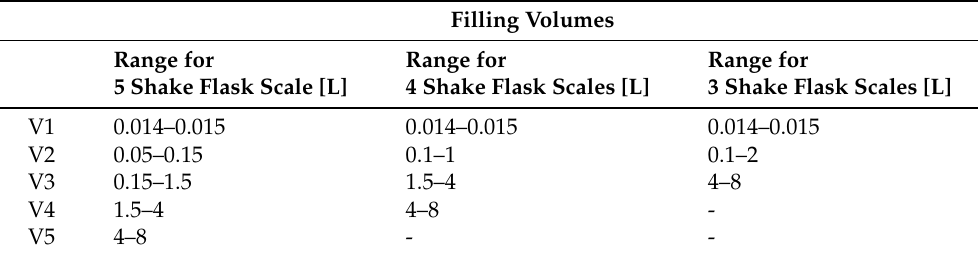
Table 2. Input space for the shake flask filling volumes, containing the possible filling volumes per scale, given for optimization runs with 5, 4 or 3 shake flask